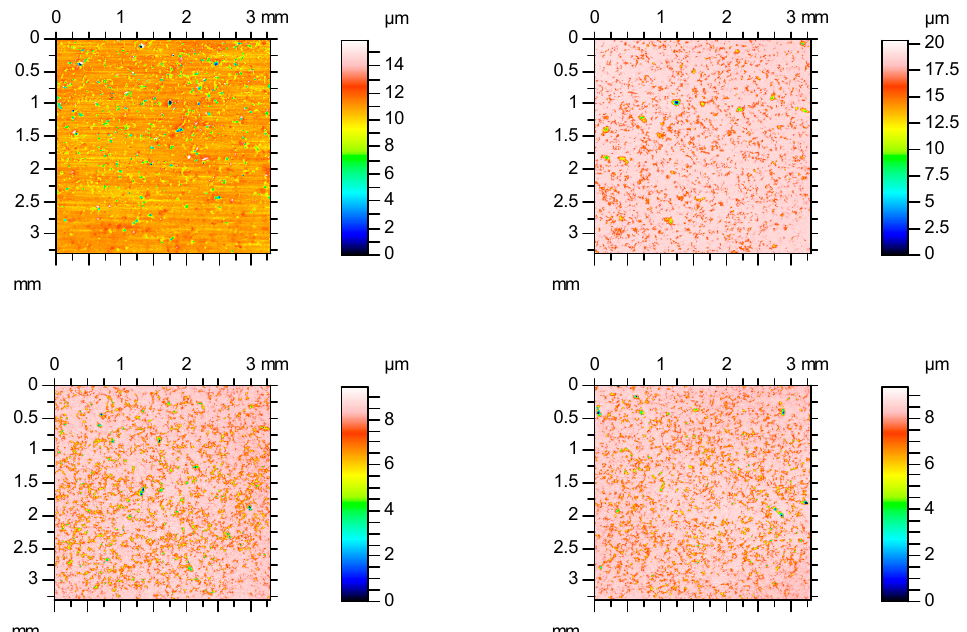
Figure 10. Contour plots of the surfaces after vapor blasting and lapping.